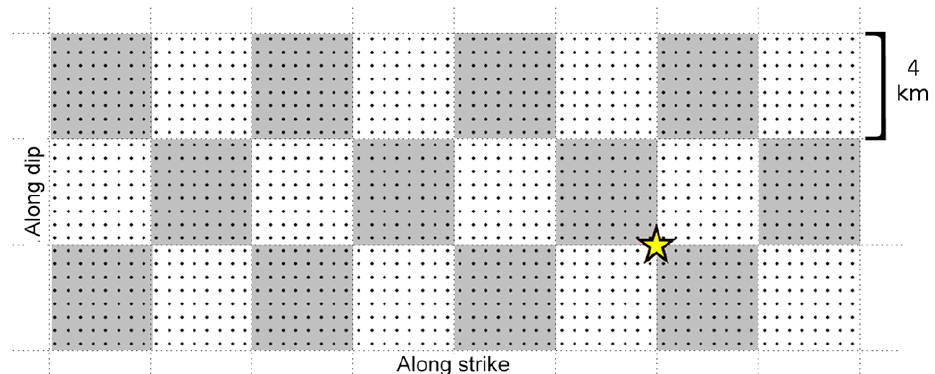
Figure 2. 2-D illustration of the fault neglecting constant third dimension. The fault is broken up into 24 subfaults, each consisting of 64 point sources. Each subfault will rupture appropriately delayed in time, depending on the distance to the hypocenter. The hypocenter (marked as a yellow star) is set to be exactly between four subfaults for easier computation of the rupture times of the